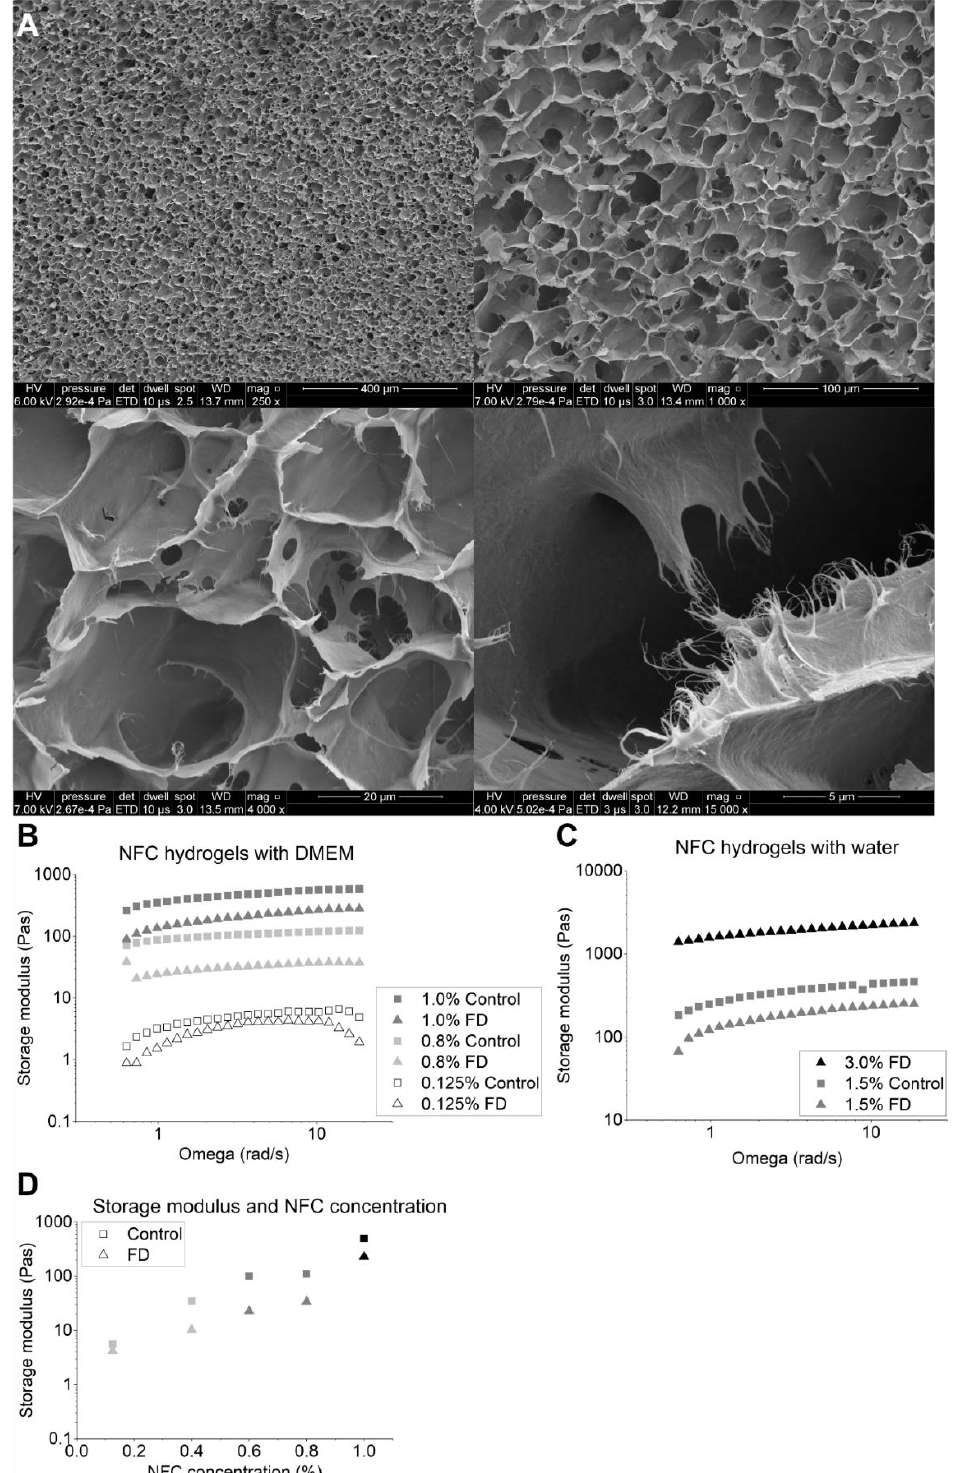
Figure 1. ( A ) Scanning electron microscope (SEM) micrographs of freeze-dried 1.5% nanofibrillated cellulose (NFC) samples with sucrose demonstrating a continuous porous structure of the freeze- dried sample. ( B ) Storage moduli of NFC hydrogels with sucrose and Dulbecco’s modified eagle medium (DMEM). Standard deviations (SD) of the measurements varied between 264.5 – 588.4 (1.0% control), 65.4 – 115.1 (1.0% FD), 71.6 – 124.2 (0.8% control), 16.5 – 44.6 (0.8% FD), 1.7 – 6.7 (0.125% Con- trol), and 0.5 – 4.5 (0.125% FD) ( C ) NFC hydrogels with sucrose only. SD of the measurements varied between 256.8 – 462.8 (3.0% FD), 183.4 – 466.0 (1.5% Control), and 38.2 – 68.2 (1.5% FD). ( D ) Storage moduli of NFC hydrogel with sucrose and DMEM at the angular velocity of 4.93 rad/s (fresh and